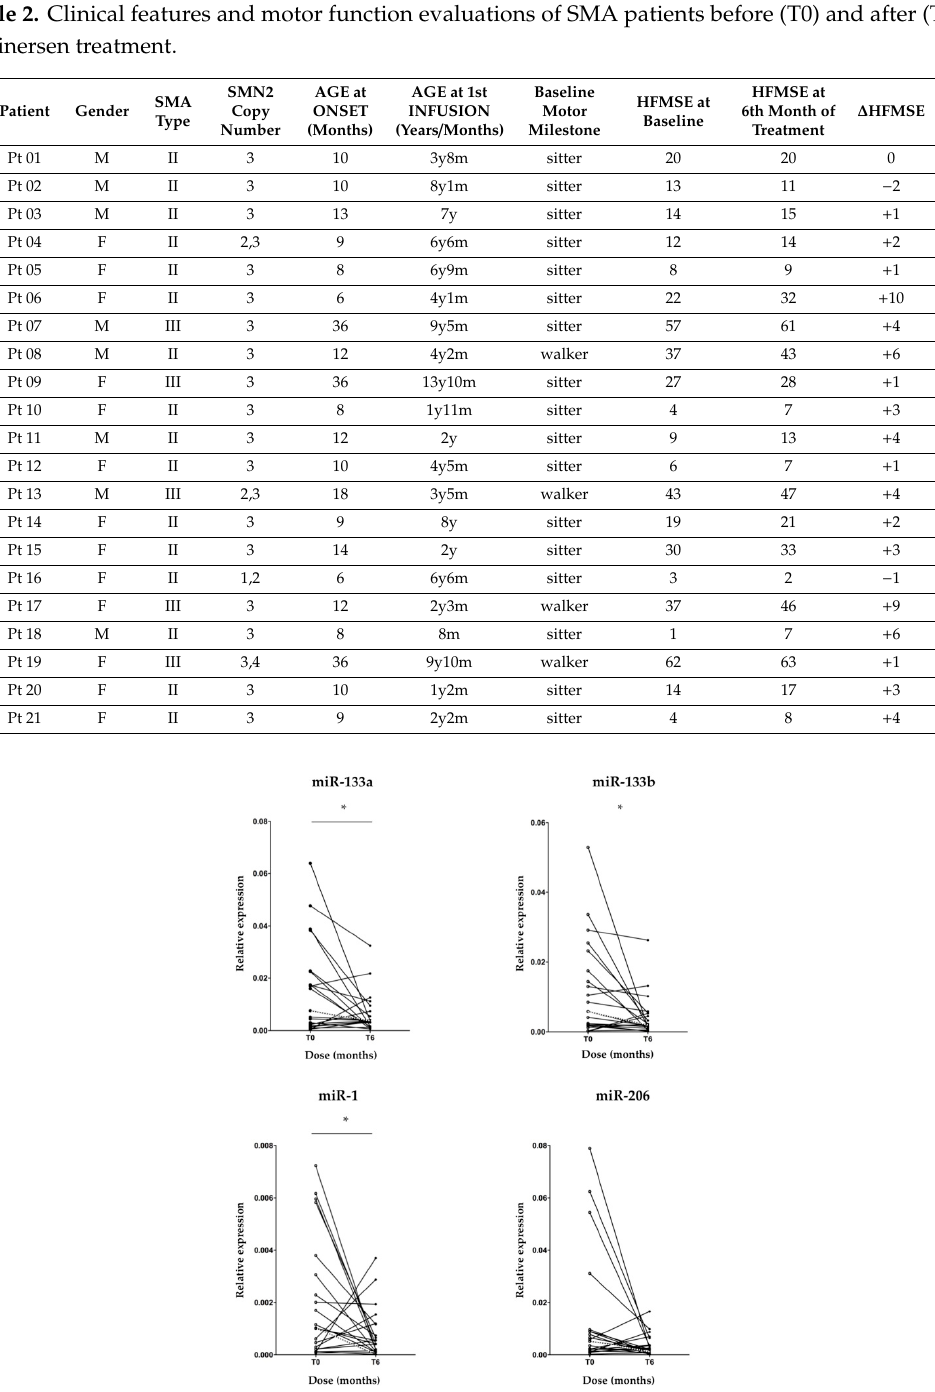
Figure 1. MyomiR expression reduction in serum of SMA patients after 6 months of nusinersen treatment. RT-PCR analysis of muscle-specific miRNAs in total RNA extracted from serum of 21 SMA patients demonstrated a significant reduction of miR-133a, -133b and -1 transcriptional levels during nusinersen treatment. A trend in reduction for miR-206 is shown. Each point represents miRNA expression level in serum of a patient at that time-point; trend lines show miRNA changes over time (solid lines). The medians of the myomiR expression levels at baseline and after 6 months of treatment are plotted accordingly for each miRNA (dotted lines). miRNA levels were normalized to miR-16 and expressed as fold changes using the 2 - Δ Ct formula. Wilcoxon signed-ranked test, * p < 0.05.